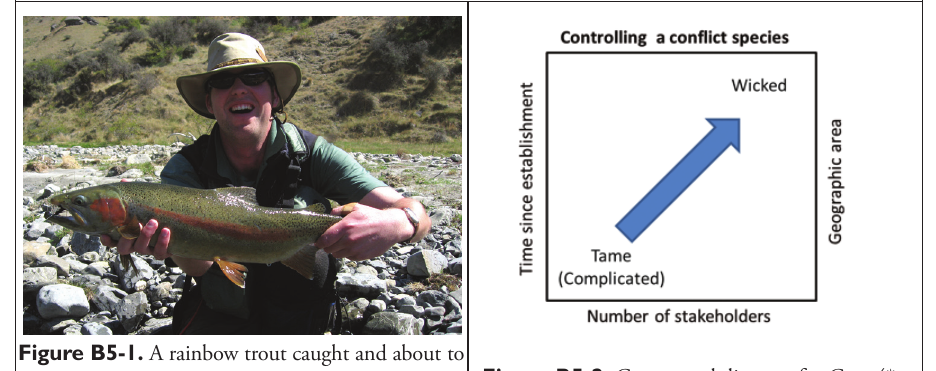
Figure B5-1. A rainbow trout caught and about to be released back into the Broken River, New Zealand. Figure B5-2. Conceptual diagram for Case